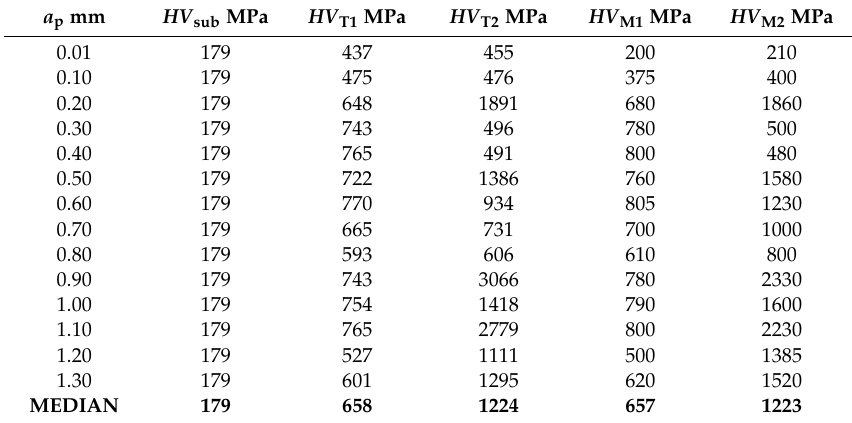
Table 4. Numerical comparison and verification of Vickers hardness.